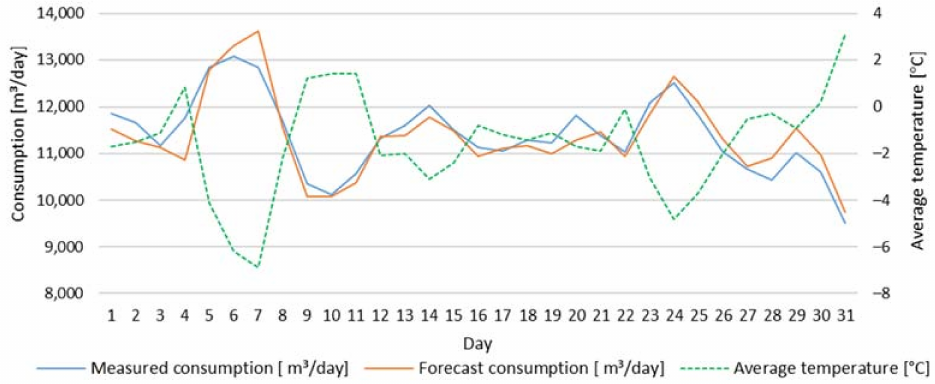
Figure 12. Comparison of natural gas consumption forecast to the actual